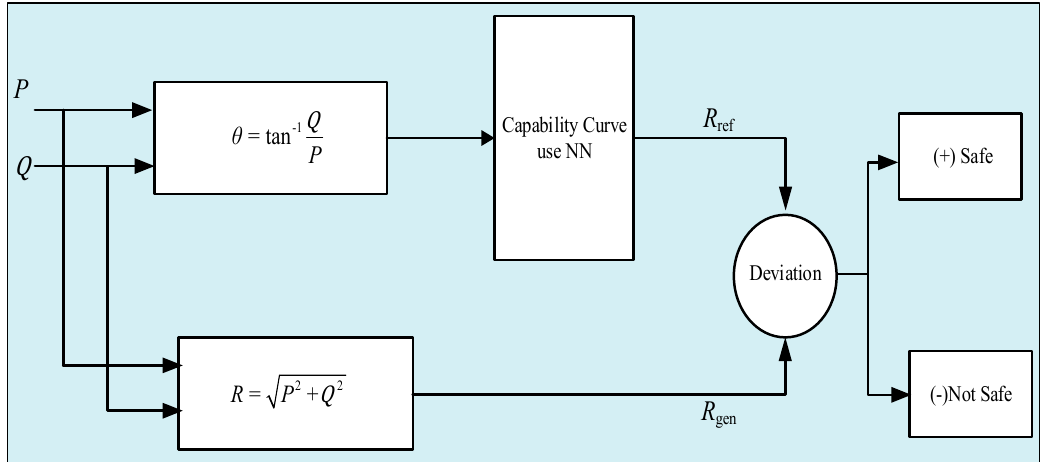
Figure 12. Generator capability curve testing algorithm.